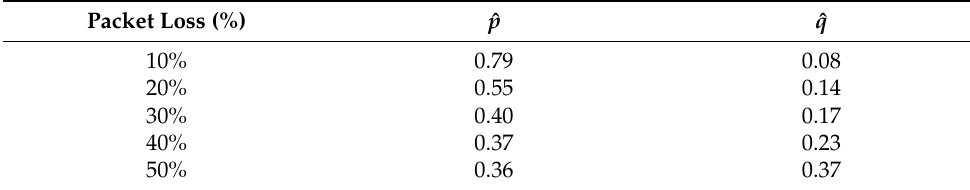
Table 3. Average calibrated values for ˆ p and ˆ q